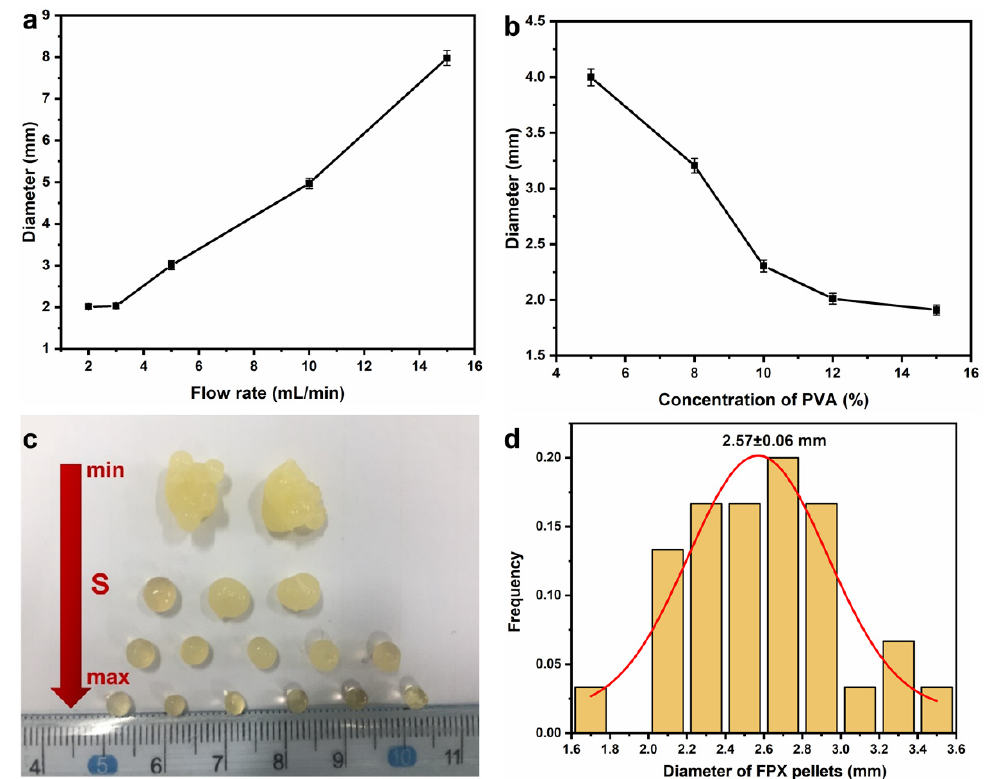
Figure 3. Optimization of preparation parameters of the FPX pellets. ( a ) Diameter of the FPX pellets at different flow rates. ( b ) Diameter of the FPX pellets at different concentrations of PVA. ( c ) Optical photograph of the FPX pellets at different oscillation speeds. ( d ) Size distribution of the FPX pellets.